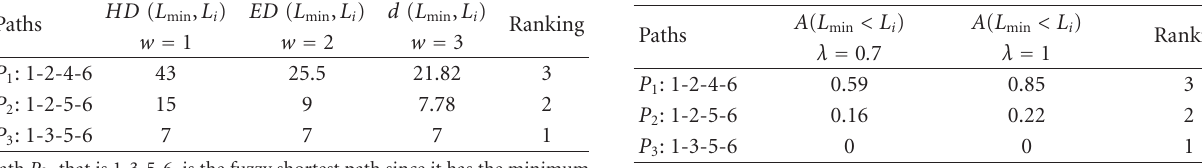
Table 3: Results of the network based on level λ -triangular LR distance index.